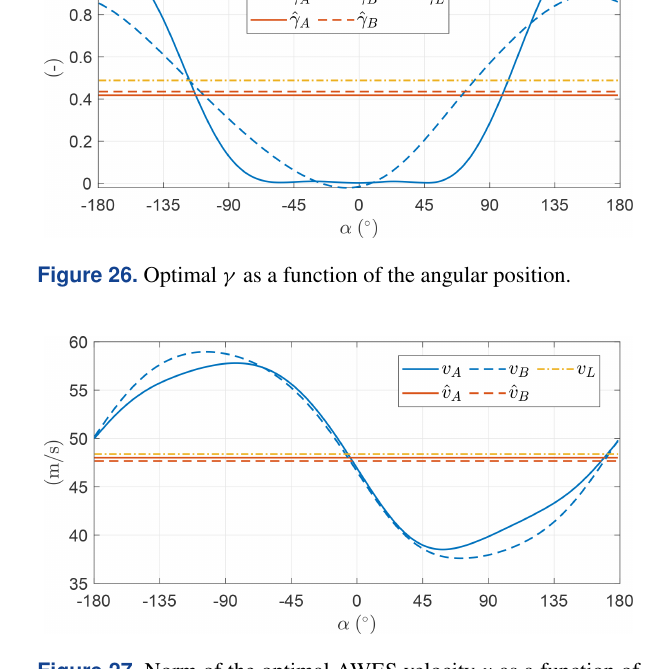
Figure 27. Norm of the optimal AWES velocity v as a function of the angular